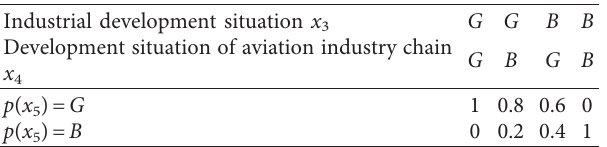
Table 4: Probability table of national economic development ex- perts’ forecast conditions in September 2019.